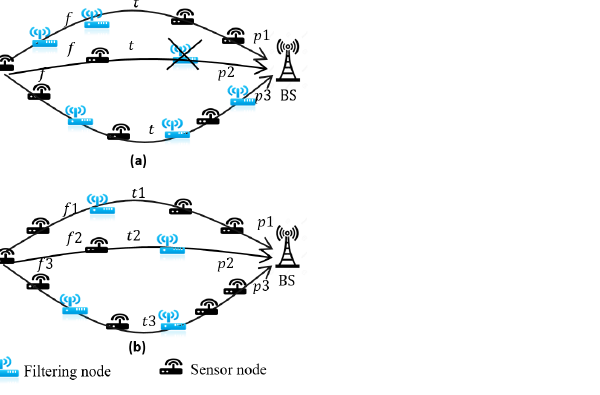
Figure 9. Network Performance analysis: ( a ) lifetime and ( b )